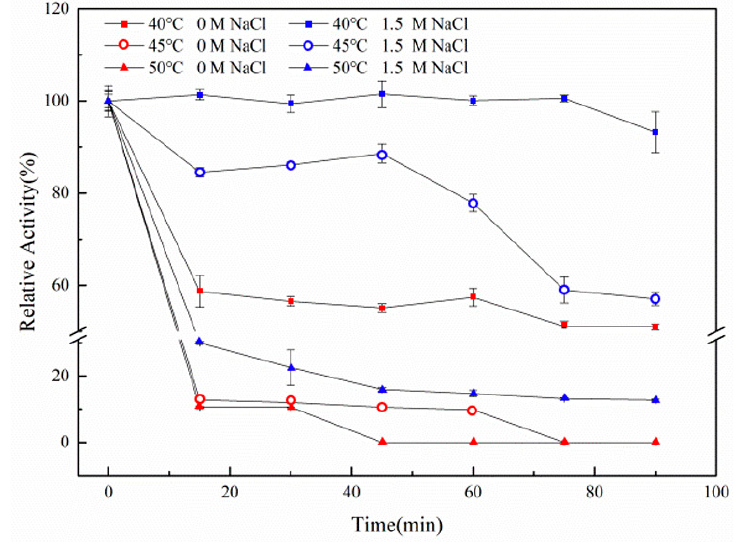
Figure 6. The influences of temperature on the stability of rXyl88.